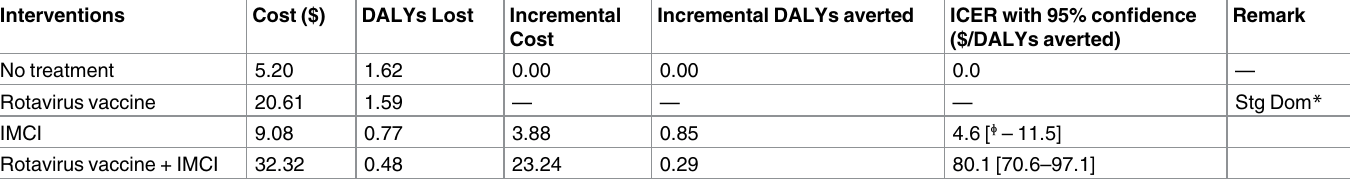
Table 3. Results showing cost, effect and ICER per patient.